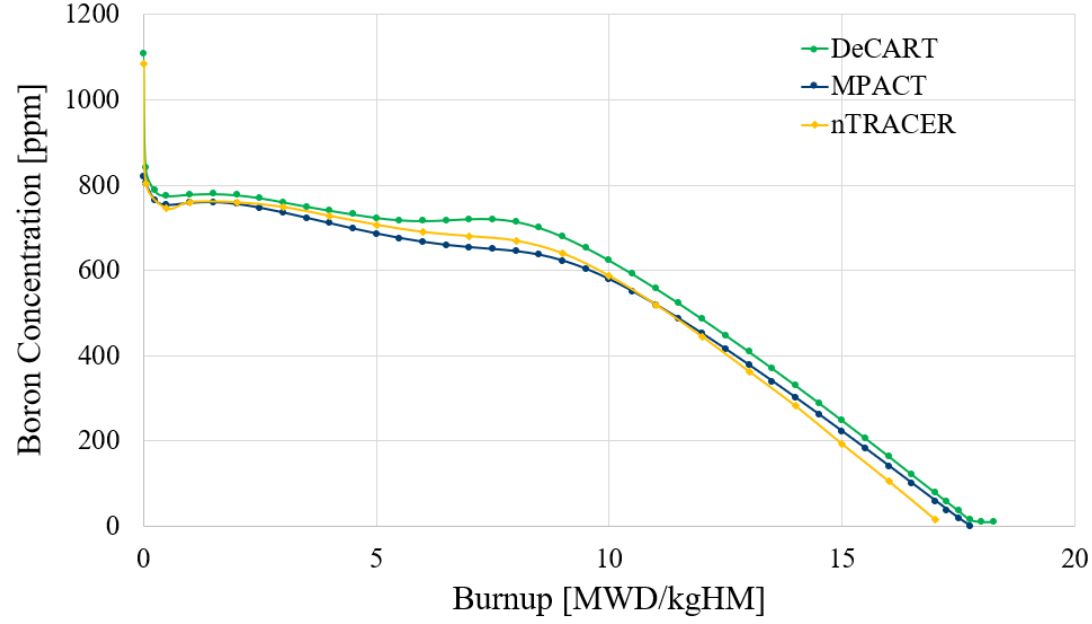
Figure 24. 3-D core depletion results in comparison to solutions generated by other benchmark